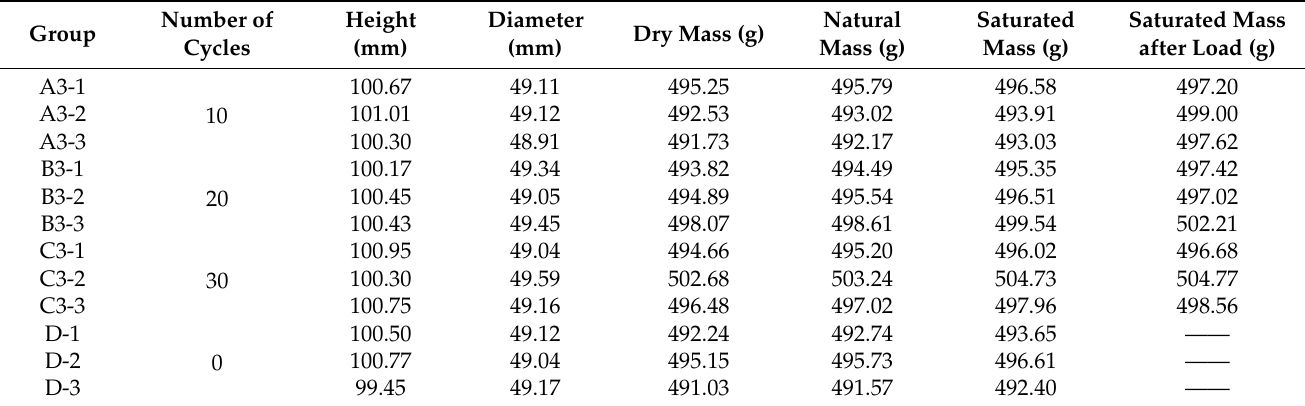
Table 1. Physical parameters of granite specimens.